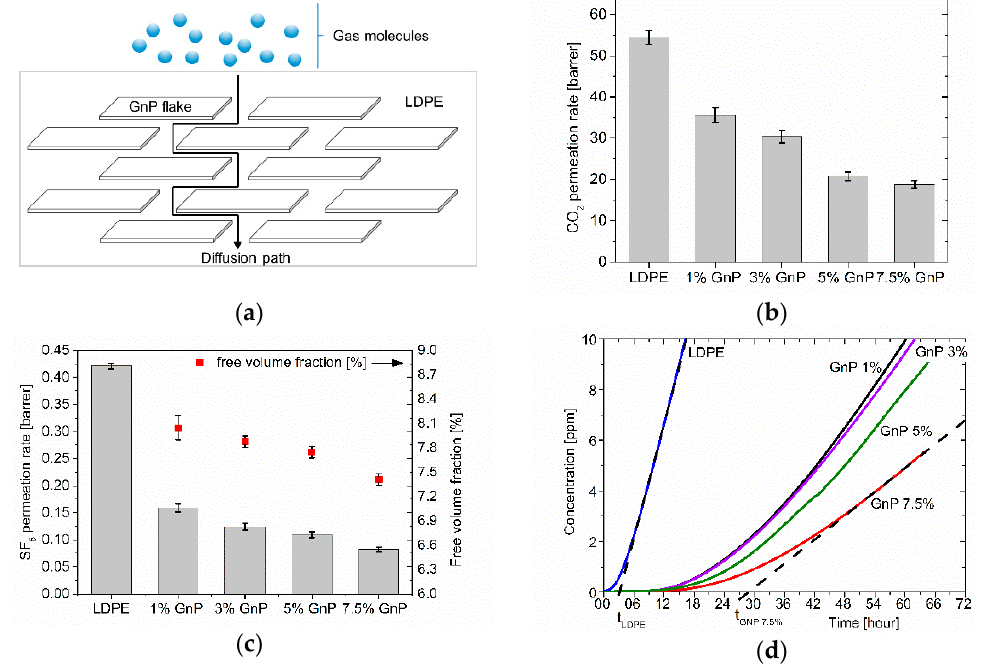
Figure 7. Schematically shown tortuous path of gas diffusion through a LDPE-GnP extruded nanocomposite ( a ); permeability of nanocomposites for CO 2 ( b ); permeability of nanocomposites for SF 6 and their free volume fractions ( c ); dependence of accumulated SF 6 leakage ( d ) for LDPE-GnP nanocomposites concentration ( t LDPE and t GNP7.5% indicate respectively delays in onset of permeation for pure LDPE and 7.5 wt % GnP samples).